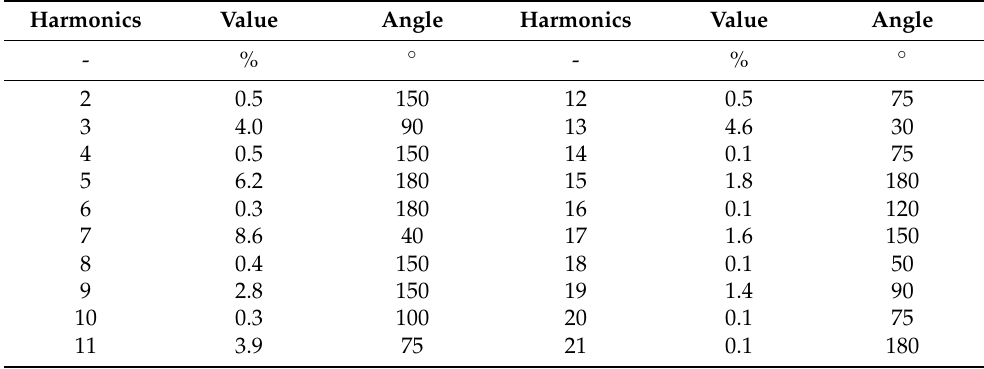
Table 5. Voltage harmonics values during